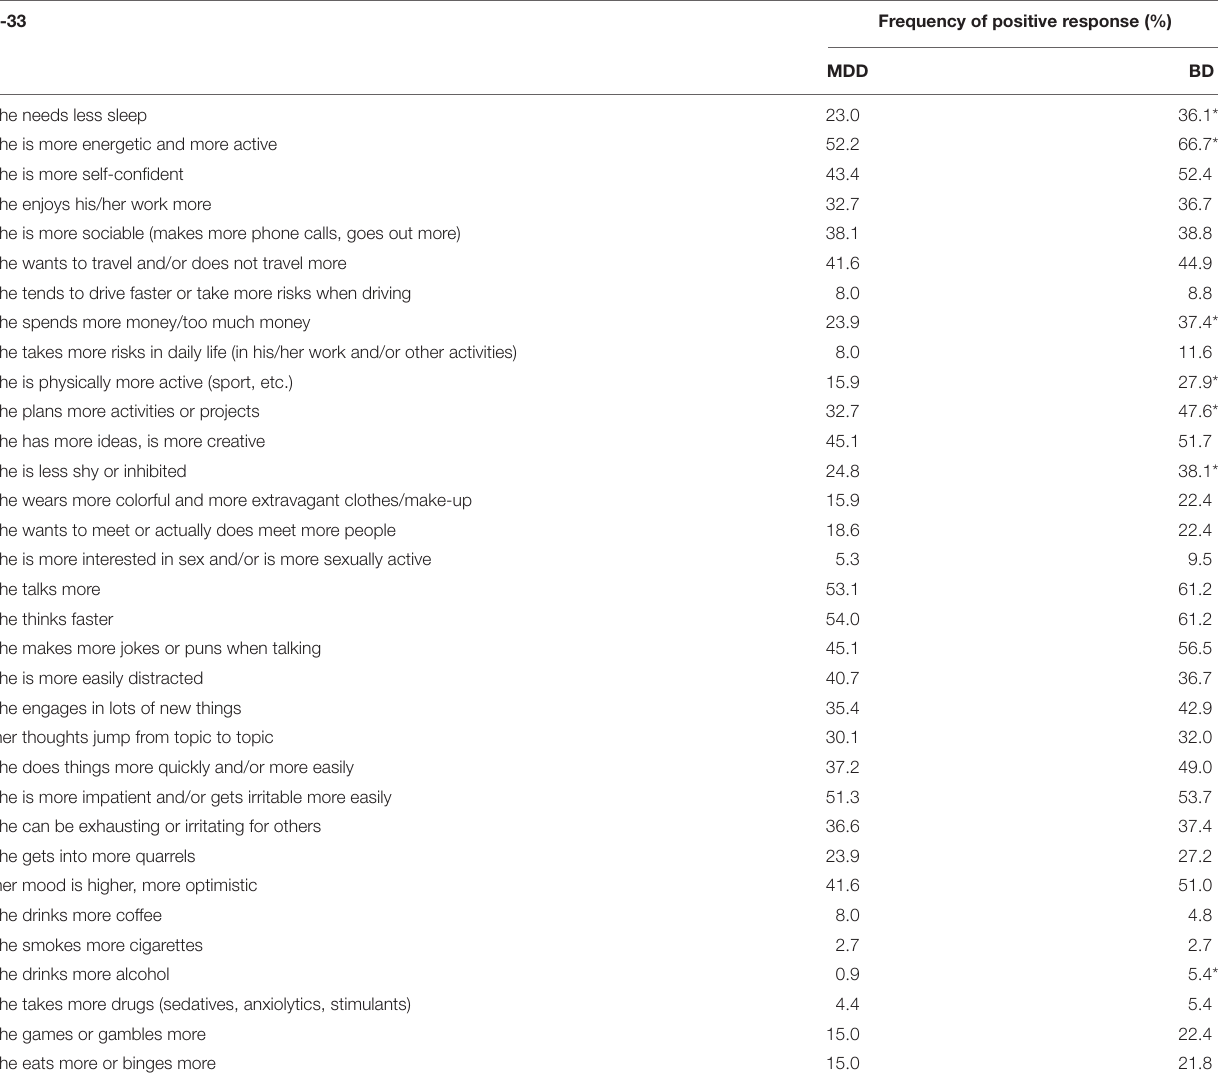
TABLE 3 | HCL-33-EA—Percentage of positive responses by carers of depressed adolescents with MDD or BD.